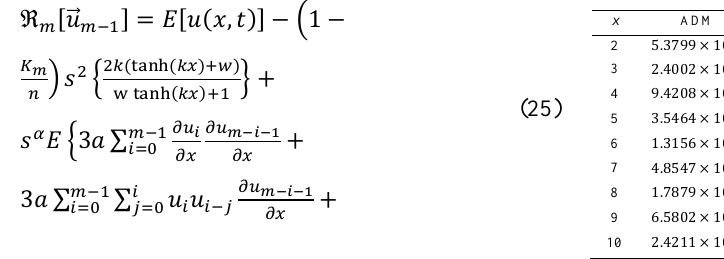
Figure 2. 𝑢(𝑥, 𝑡) versus 𝑡 for contemplated, Ex. 1. when ℏ = −1 , 𝑥 = 5,𝑎 = 1, 𝑘 = 0.1,𝑤 = 0.5, and 𝑛 = 1 for distinct 𝛼 . Table 1. Absolute errors of ADM, HPM, OHAM [63], and the q -HAETM for Ex. 1 at 𝜶 = 𝟏, 𝒏 = 𝟏, 𝒌 = 𝟏,𝒂 = 𝟏,ℏ = −𝟏, 𝒘 = 𝟎.𝟓 and 𝒕 = 𝟎. 𝟎𝟏